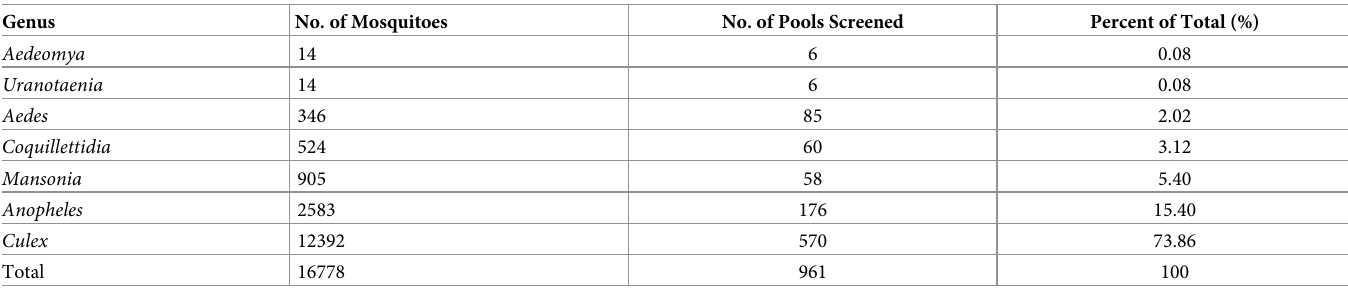
Table 2. Composition of mosquito species collected during the study